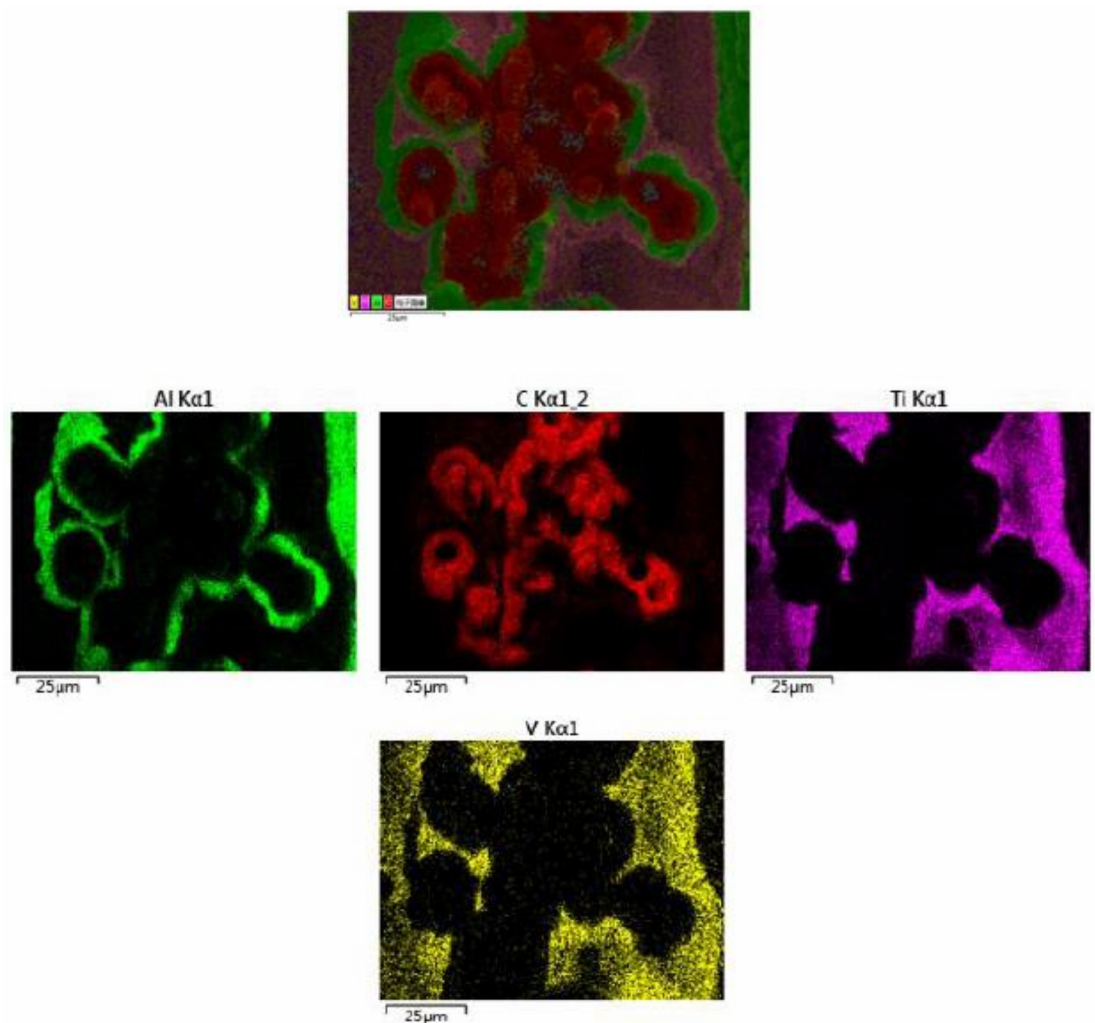
Figure 7. The EDS maps image of the section of Cf / C-TiC